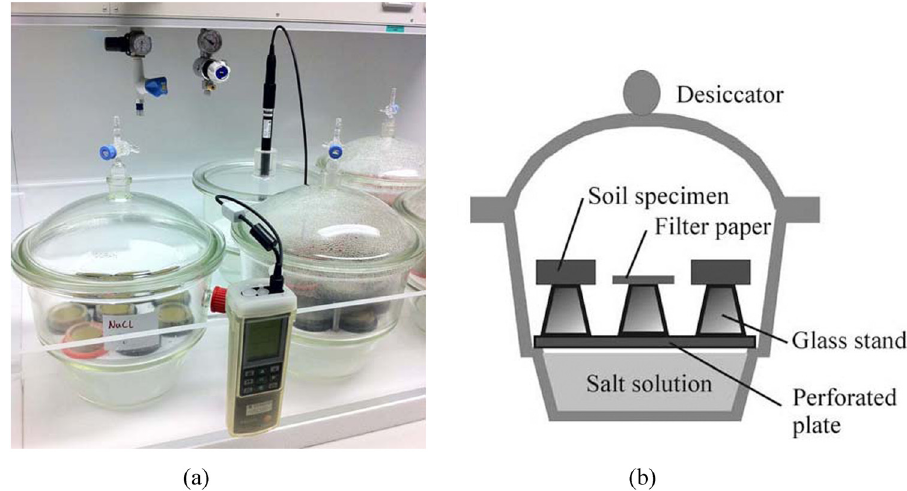
Figure 2: Constant relative humidity desiccators with vapour equilibrium technique ( VET ) : ( a ) desiccators set up; ( b ) schematic plot.